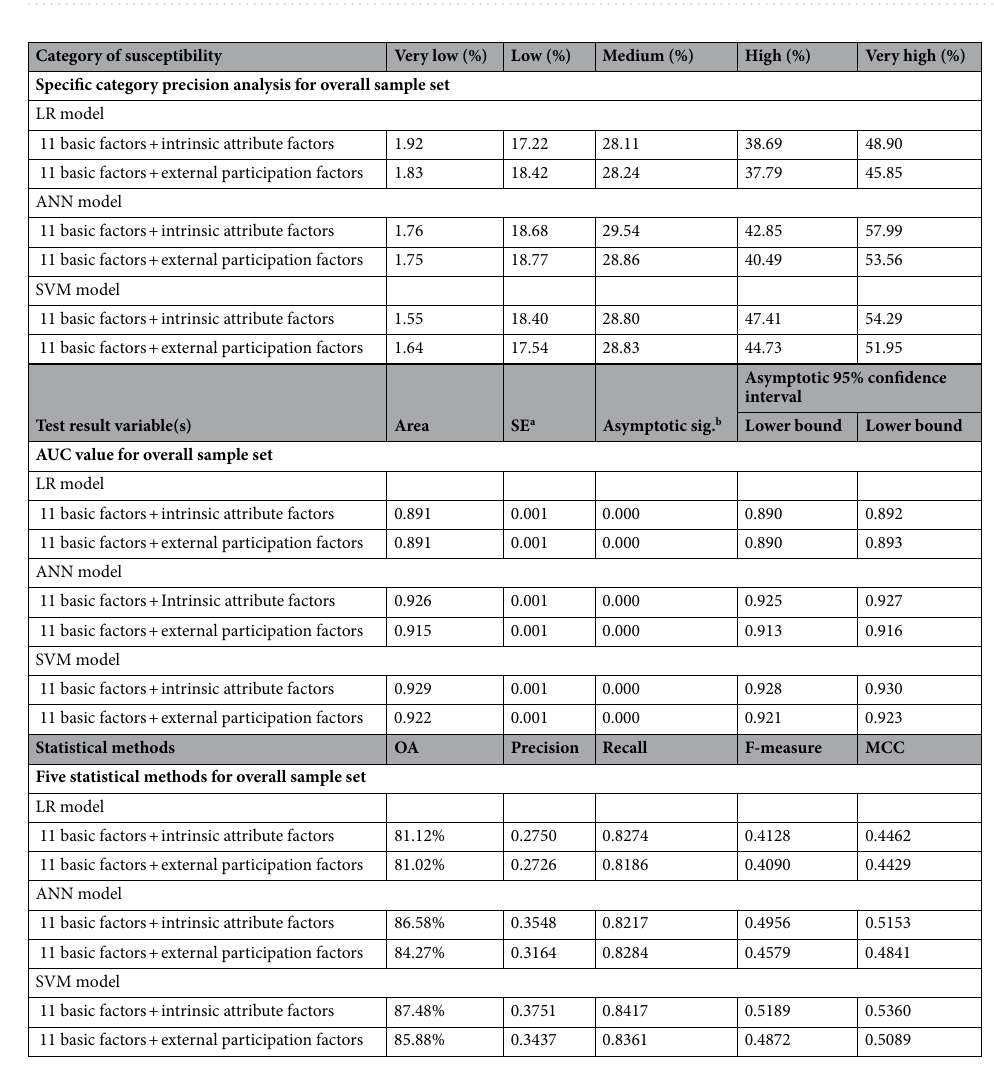
Table 10. The result of different evaluation methods based on Intrinsic attribute factors and External participation factors. a Under the nonparametric assumption. b Null hypothesis: true area = 0.5.